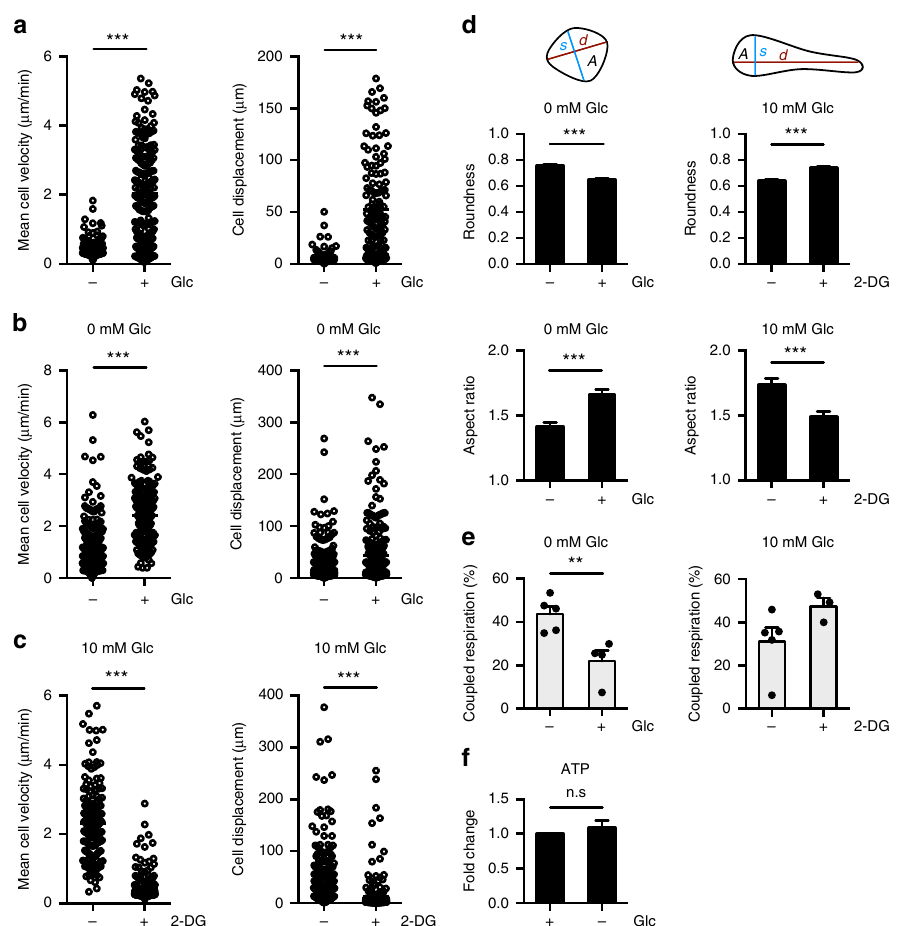
Fig. 5 Glycolysis is required for DC motility and morphology. Images of DCs were captured over time using confocal microscopy. a Mean cell velocity (left) and cell displacement (right) of DCs in the presence or absence of 10 mM glucose after 4 h. b Mean cell velocity (left) and cell displacement (right) of DCs cultured in the absence of glucose following the addition of media with or without 10 mM glucose. c Mean cell velocity (left) and cell displacement (right) of DCs cultured in the presence of glucose after the addition of media with or without 10 mM 2-deoxyglucose (2-DG). d Roundness (4 × A /( π × d 2 ); top left) and aspect ratio ( d / s ; bottom left) of DCs cultured without glucose after the addition of media with or without 10 mM glucose, and roundness (top right) and aspect ratio (bottom right) of DCs cultured in the presence of glucose after the addition of media with or without 10 mM 2-DG. e Coupled respiration as a percentage of total respiration of DCs cultured without glucose and following the addition of glucose (left), and of DCs cultured in the presence of glucose and following the addition of 2-DG (right). f Fold change of ATP levels in DCs cultured with or without glucose relative to glucose condition. Data in a represent 164 – 210 cells. Data in b – d represent 179 – 268 cells from one experiment representative of two experiments. Data in e are three to fi ve experiments (depending on condition) (mean and s.e.m.). Data in f are fold changes of three experiments (mean and s.e.m.). Data